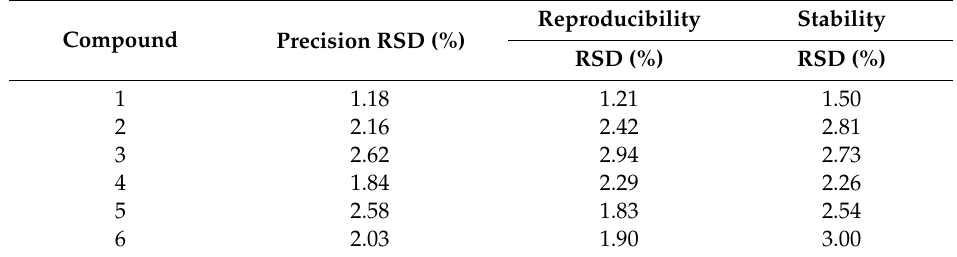
Table 4. The reproducibility, precision, and stability of extractions using Psorslea corylifolia L. extracts.